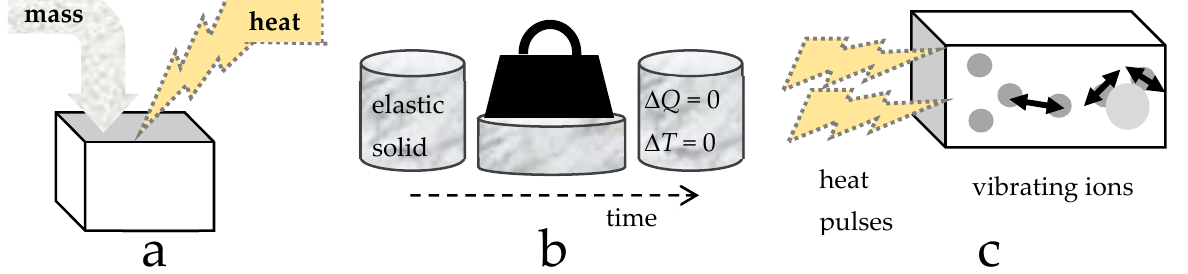
Figure 4. Schematics of an ideal, perfectly elastic solid: ( a ) any given volume can contain a quantity of mass, and can independently contain some quantity of heat-energy; this independence underlies our model; ( b ) Essence of elastic behavior. Squeezing (increasing pressure) changes V , and thus does P - V work, but does not generate heat so T is unchanged. Upon release of pressure, a perfectly elastic frictionless solid returns to its initial volume. See text for discussion of shear and shape changes; ( c ) Receipt of small amounts of heat by a PFES. Within a short, but finite, distance, the pulse encounters vibrating ions. When energy of the applied light matches some transition energy, the affected vibrations become excited, attaining a higher energy state (e.g., an overtone). Subsequent interchanges give an overall higher vibrational energy of the collection, which imparts a higher temperature. Both steps take time.